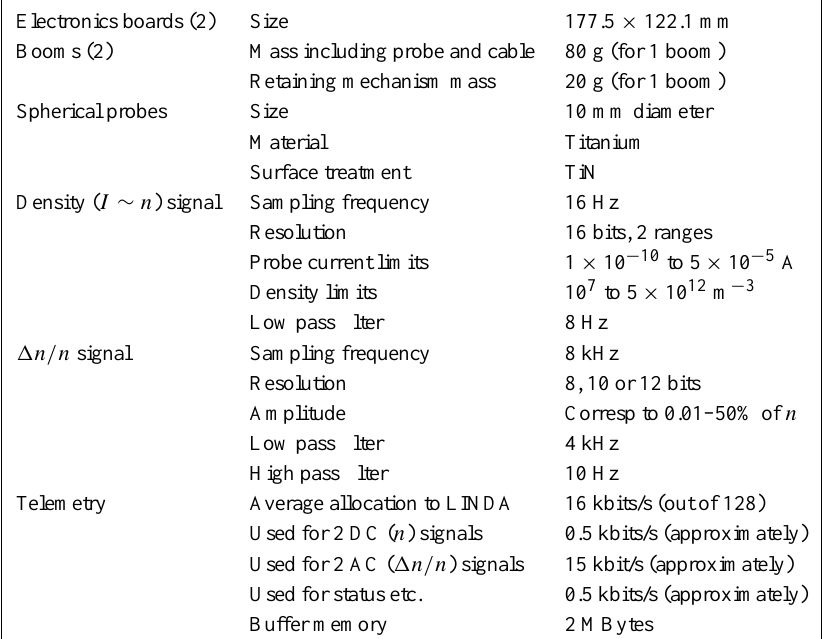
Table 1. LINDA specifications